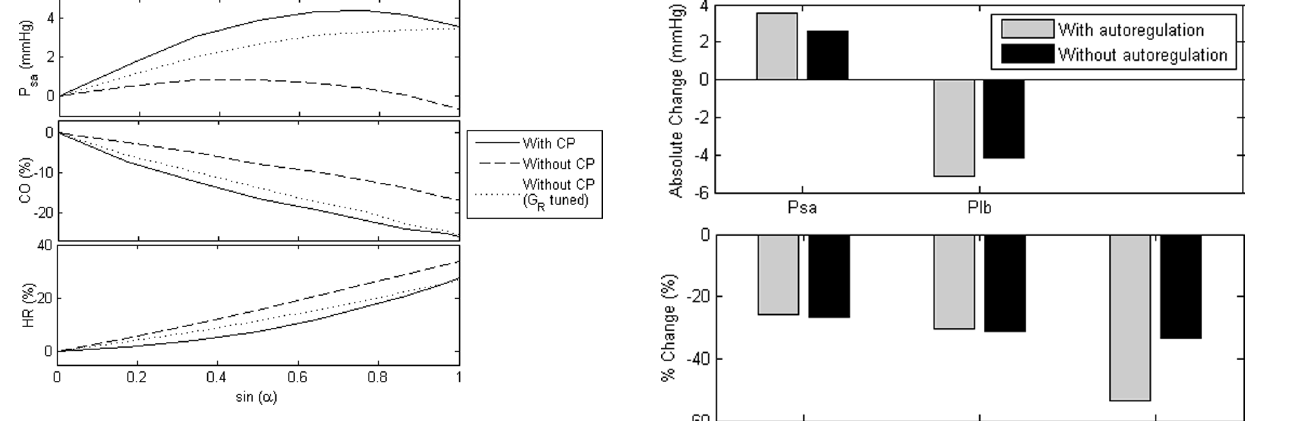
Figure 4. Effect of cardiopulmonary (CP) reflex on mean arterial pressure ( P sa ), mean cardiac output ( CO ), and heart rate ( HR ). Absolute value change in the mean arterial pressure ( overlineP sa ), as well as percentage changes in the cardiac output ( CO ) and heart rate ( HR ), at varying levels of tilt angles ( a ) for the healthy condition. With CP: with CP reflex intact; Without CP: without CP reflex; Without CP ( G R tuned): without CP reflex, but with all the four efferent resistance gains tuned to yield the same resistance values as that with CP reflex intact, at supine and 80 o HUT.